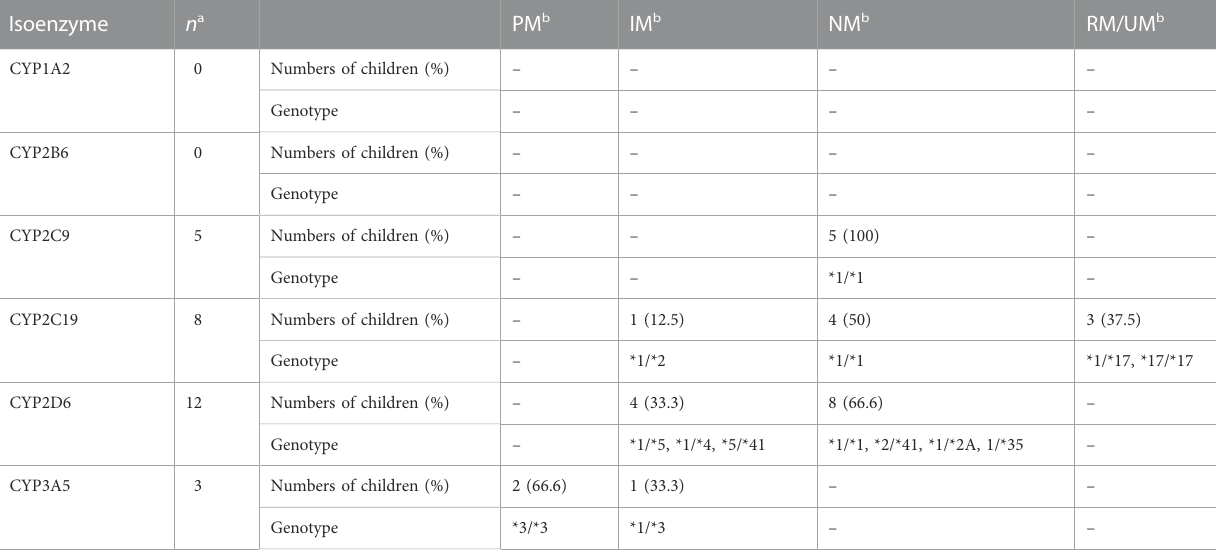
TABLE 1 CYP predicted phenotype based on the identi fi ed alleles in patients with simultaneous genotyping and phenotyping. Isoenzyme